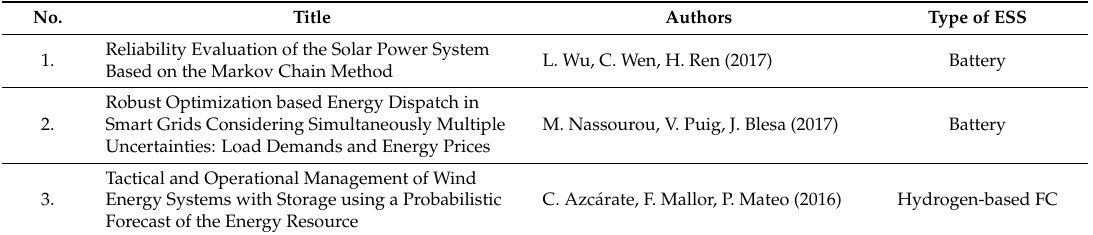
Table A1. Articles included in systematic literature review